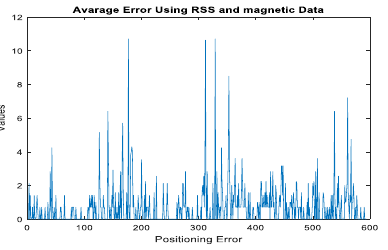
Fig. 5. Positioning error for all the fingerprints of the dataset when both WAPs RSS values and magnetometer is